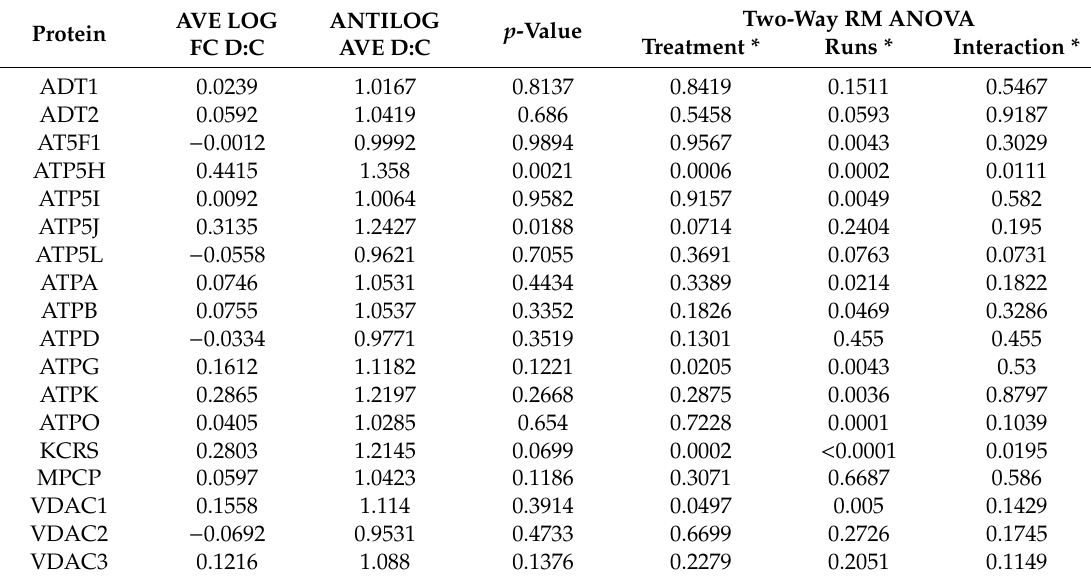
Table 2. Analysis of the treatment e ff ects on exponentially transformed protein abundance index (emPAI) values on the logarithmic